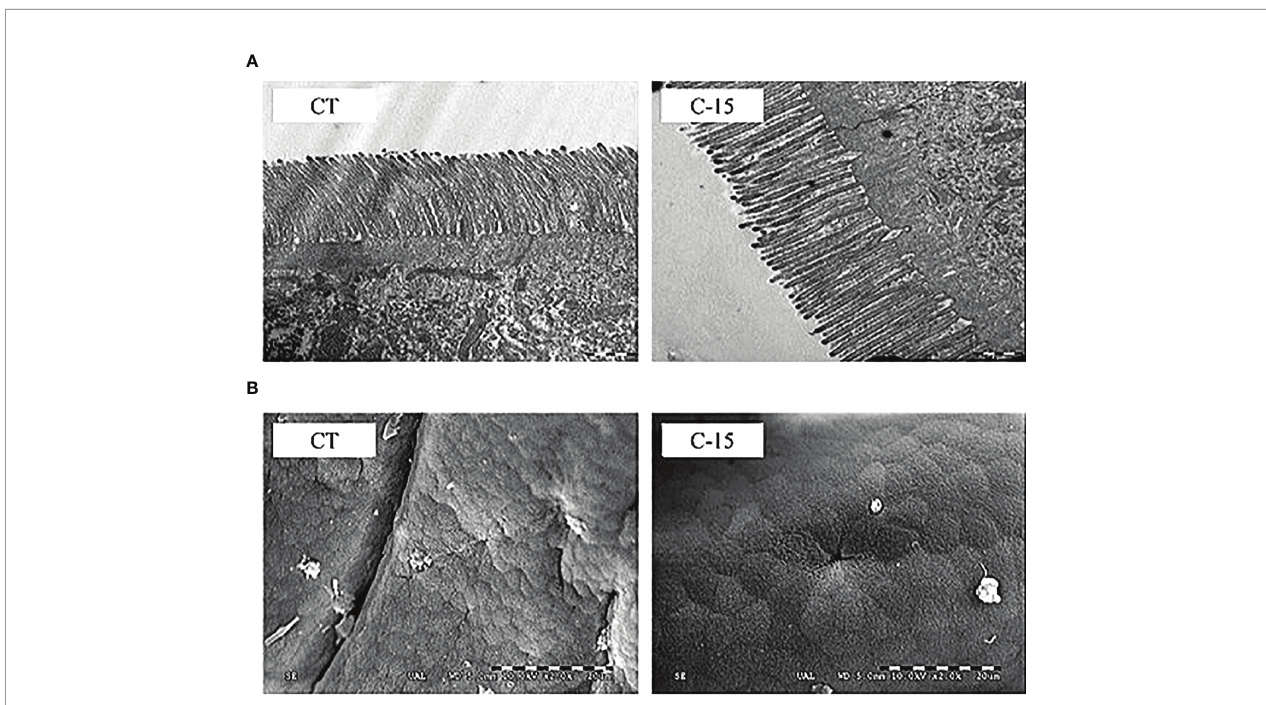
FIGURE 3 | Comparative TEM (A) and SEM (B) micrographs from the anterior intestine of C. labrosus juveniles at the end of the feeding trial. Dietary codes: CT, control diet; C-15: 15% C. fusca supplemented-diet. (TEM bar: 1 mm, SEM bar: 20 mm).